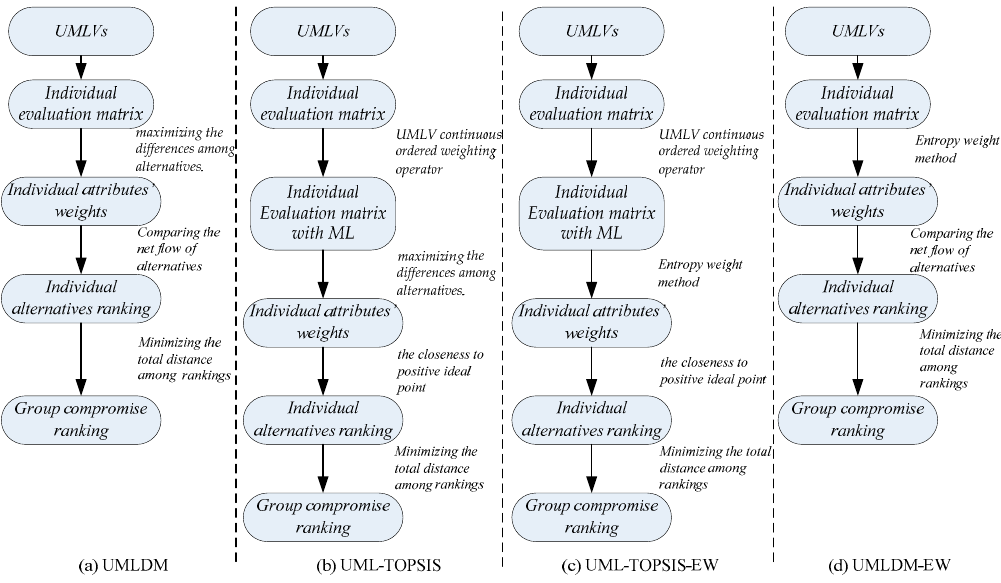
Figure 6. The procedure of 4 similar algorithms based on group compromise framework.